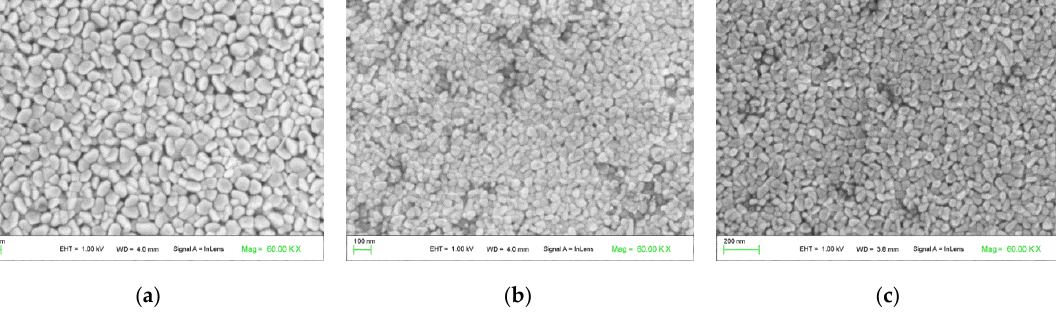
Figure 3. SEM (scanning electron microscopy) images of the surface morphology of the ZnO and (Co, Mn)-co-doped ZnO samples: ( a ) ZnO; ( b ) (Co 1%, Mn 1%) co-doped ZnO; ( c ) (Co 2%, Mn 1%) co-doped ZnO.